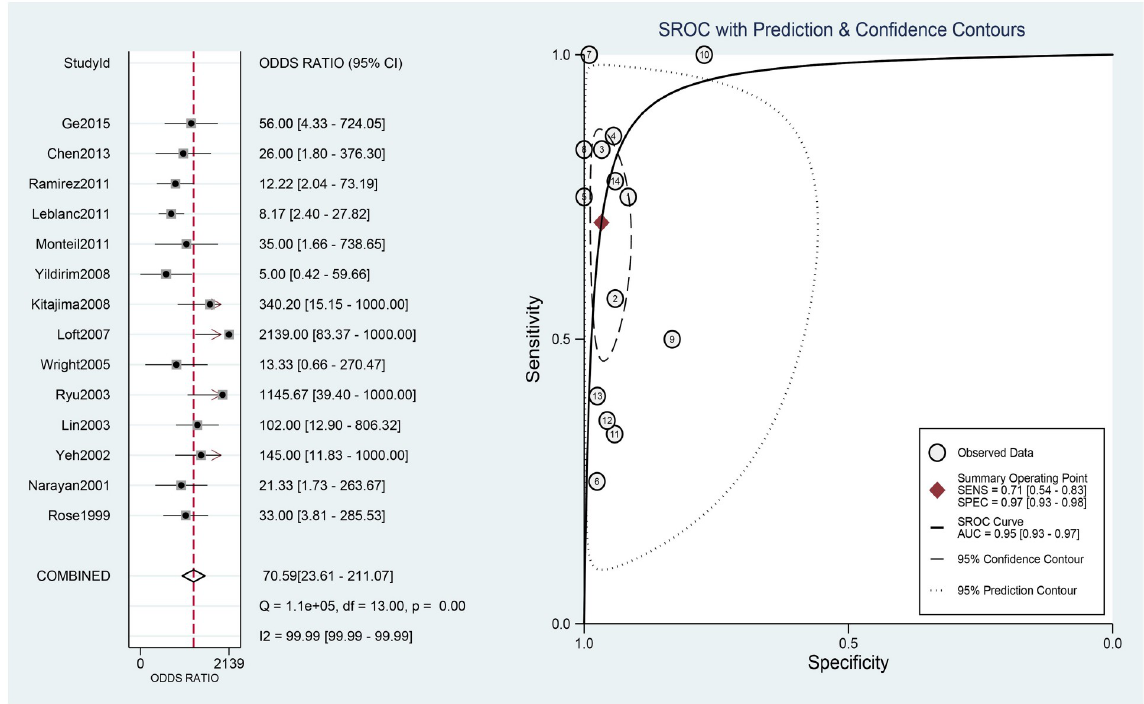
Fig 5. Forest plots for the DOR and the SROC curve. Abbreviations: CI, confidence interval; df, degrees of freedom; DOR, diagnostic odds ratio; AUC, area under the curve; SROC, summary receiver operating characteristic.